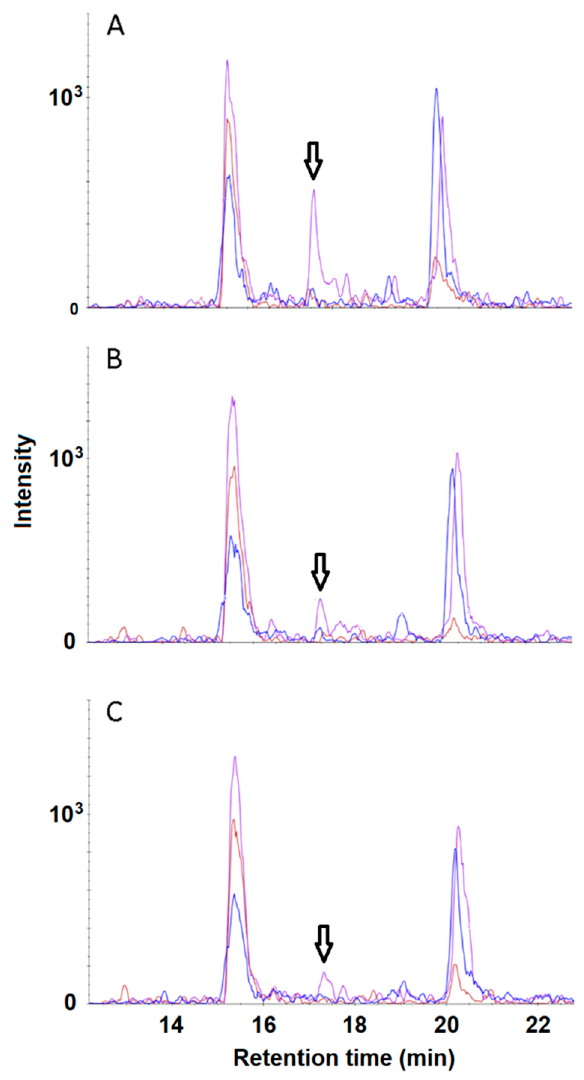
Figure 2. SRM spectra of proteotypic peptide IYPSAYIK of SMAD4 for samples derived from human plasma. The most intensive transition (y6 ‘daughter’ ion) is shown by the arrow. The concentrations of SMAD4 spiked in plasma are 50 nM ( A ), 10 nM ( B ), and 5 nM ( C ). Spectra were visualized with Skyline 3.6.0 software.